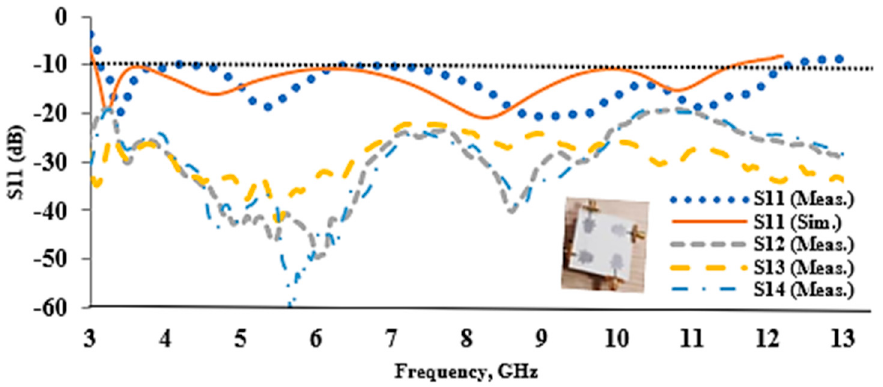
Figure 7. S-parameters of the proposed UWB MIMO antenna.